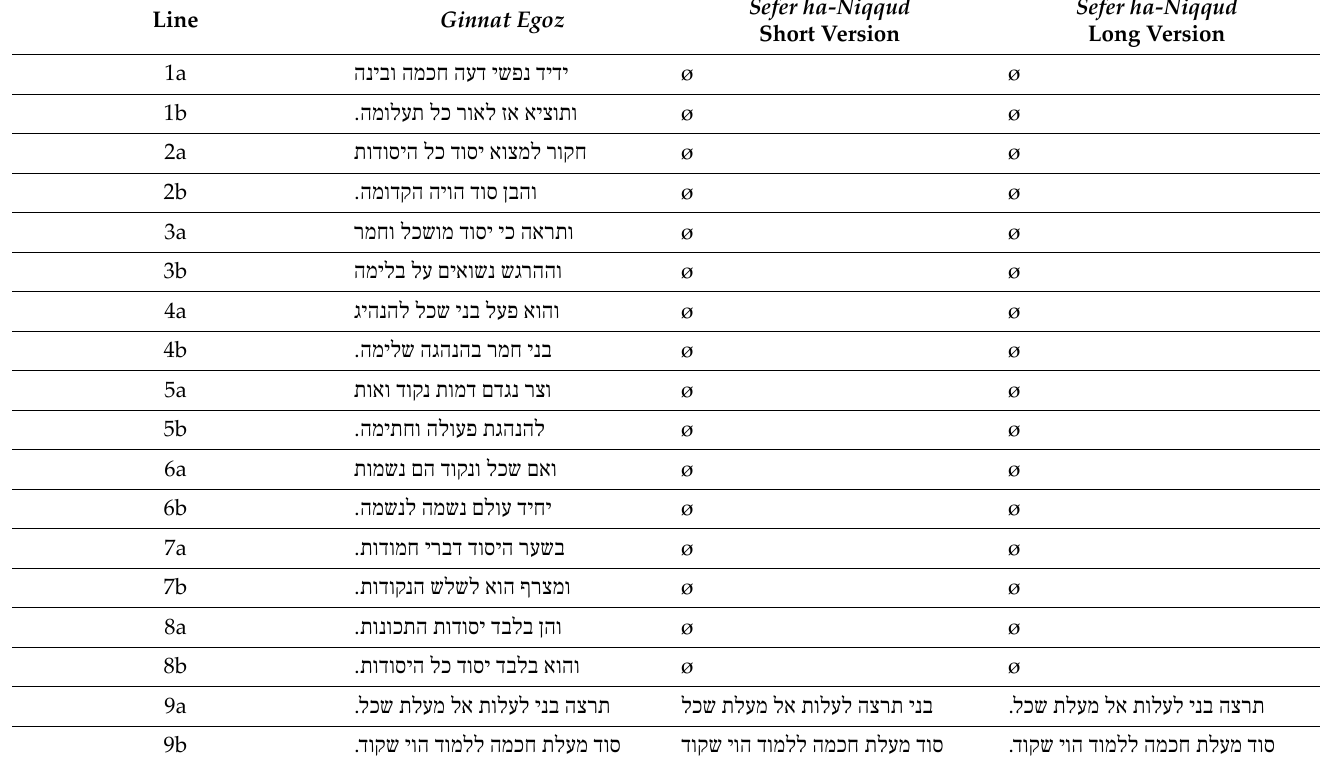
Table 1. A Synoptic Edition of Gikatilla’s Poems on Hebrew